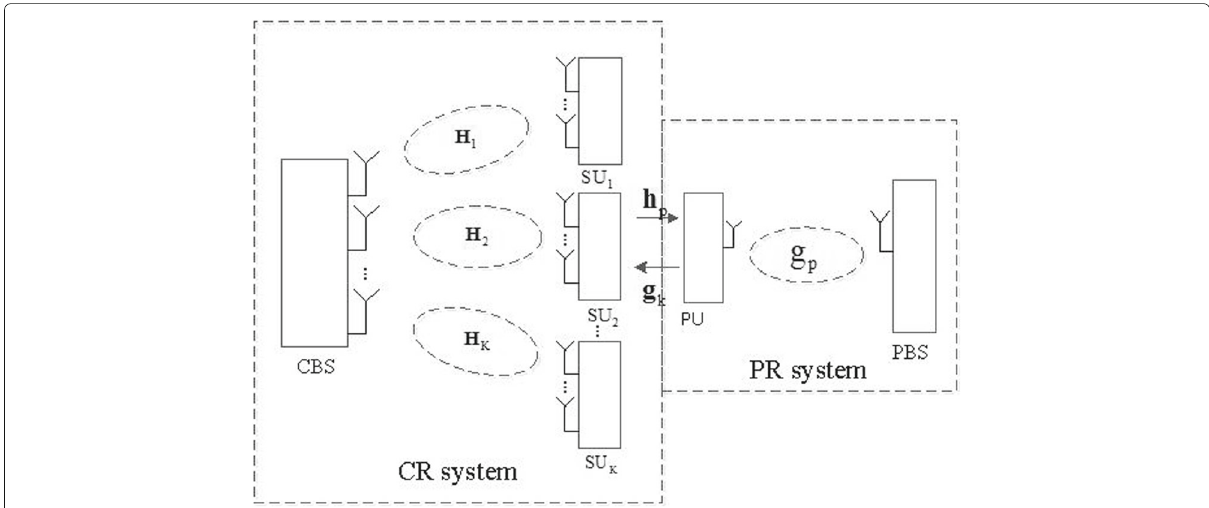
Fig. 1 The system model for CR MIMO-BCs. The CBS has N t antennas, and each SU is equipped with N r antennas. The PBS and PU are equipped with a single antenna,